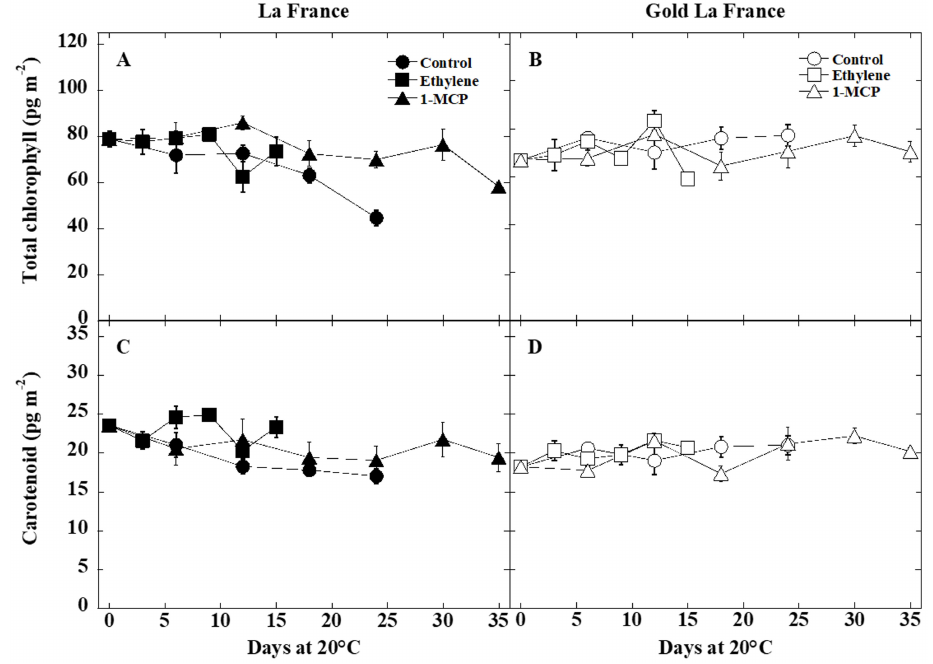
Figure 5. Changes in total chlorophyll ( A , B ) and carotenoid ( C , D ) concentration of ‘LaFrance’ and ‘Gold La France’ fruit treated with ethylene and 1-MCP during ripening at 20 ◦ C. Values represent the means ± standard errors ( n =